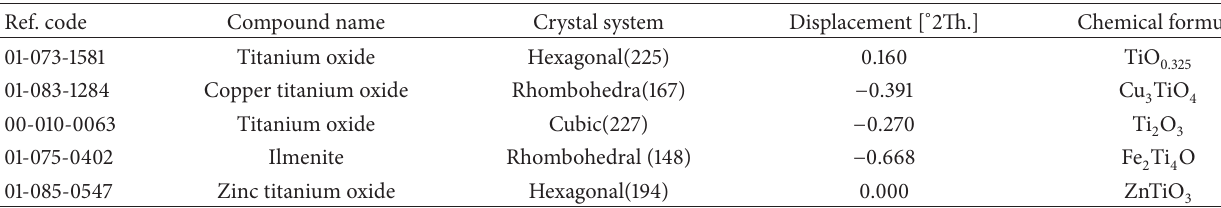
Table 6: XRD plot of identified phases.